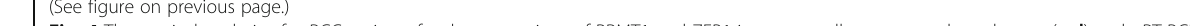
Table 8 Survival analysis. Mean survival of the patients within all types ( n = 194) and ccRCC ( n = 120); univariate and multivariate cancer-specific survival in the patients with ccRCC according to analyzed immunohistochemical markers and clinic-pathologic parameters Prognostic Cancer-specific survival (months) factors